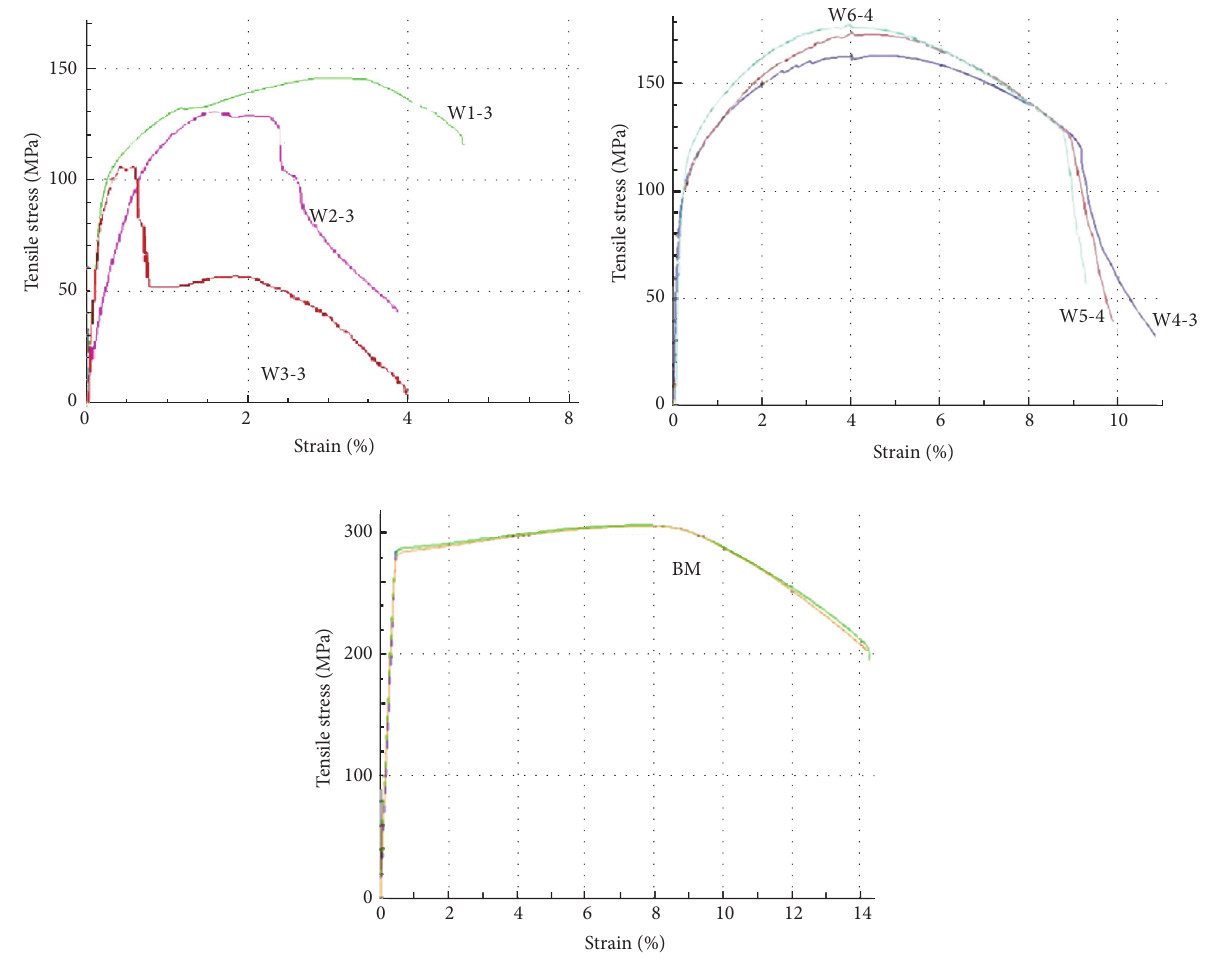
Figure 7: Tensile tests for welded and base material specimens.